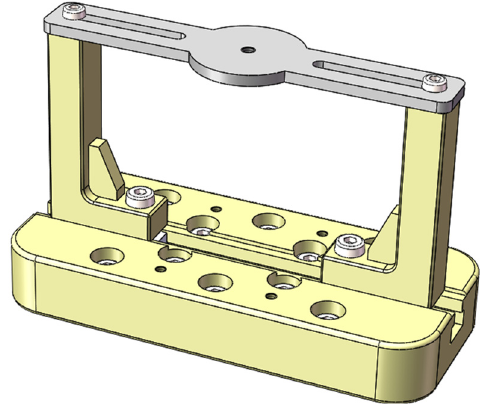
Figure 5. Simplified model of the resonant beam. Table 1. Main parameters of resonant beam material.